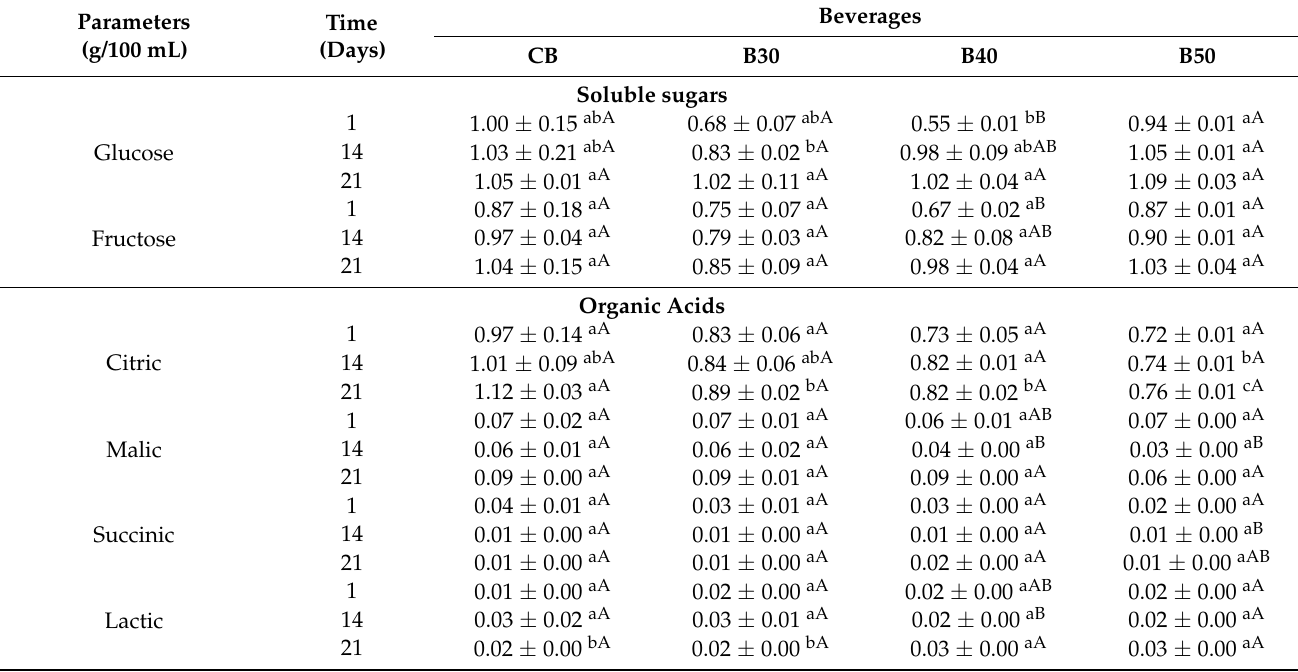
Table 3. Soluble sugars and organic acids content of formulated beverages during 21 days of refrigeration storage (4 ◦ C).